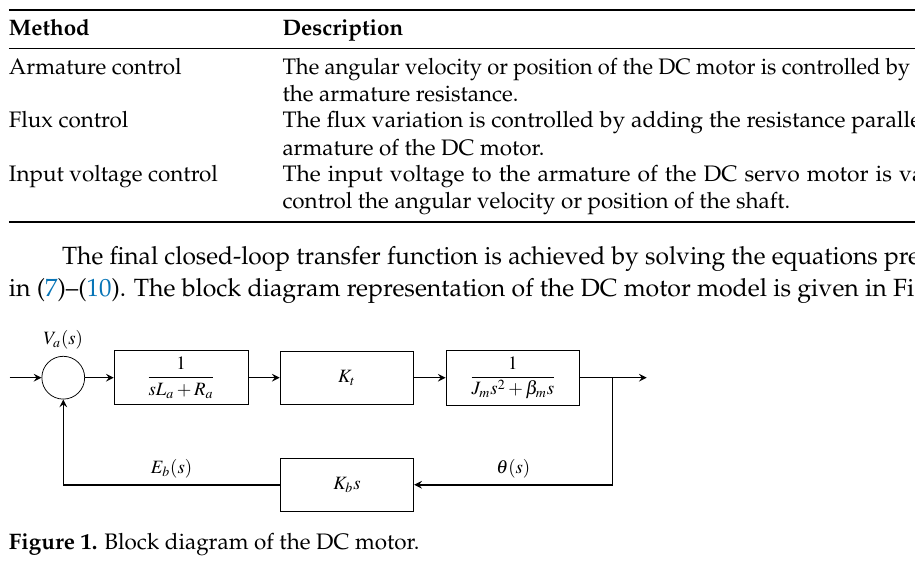
Table 3. Control methods for the DC motor.